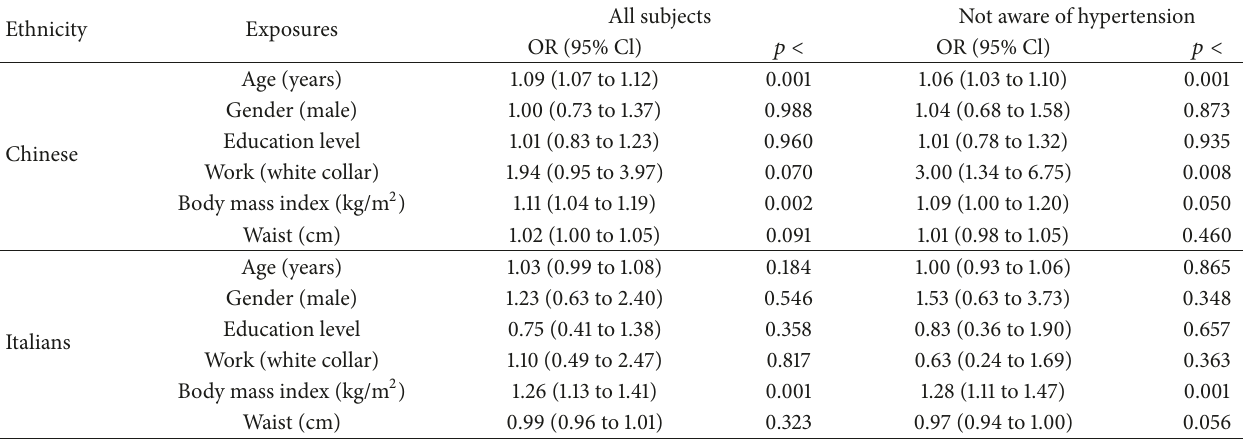
Table 3: Association between exposures and hypertension at multivariate logistic regression (adjusted for all exposures reported in the table) performed among Chinese and Italian participants.